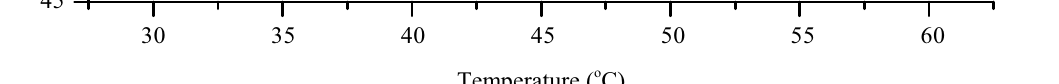
240 mg/L; adsorbent dosage of 0.04 g/L; pH =